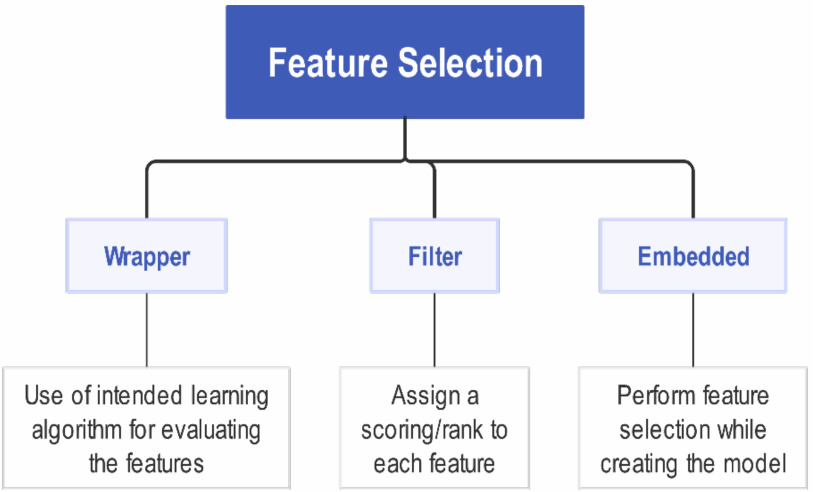
Figure 6. Various categories of feature-selection